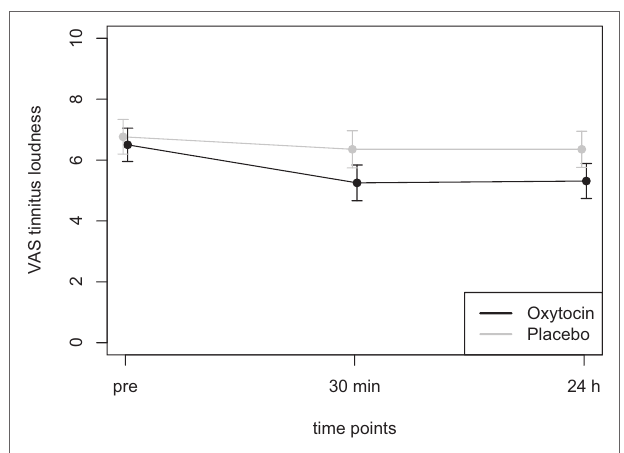
FigUre 3 | Average scores of the Visual Analogue Scale (0–10) before the treatment and at two time points after the intervention (30 min and 24 h